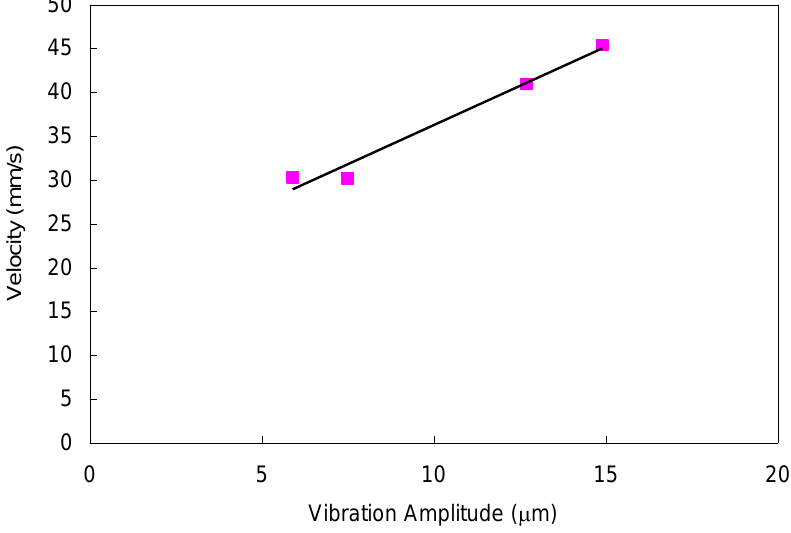
Figure 10. Velocity versus vibration amplitude for the 686 Hz